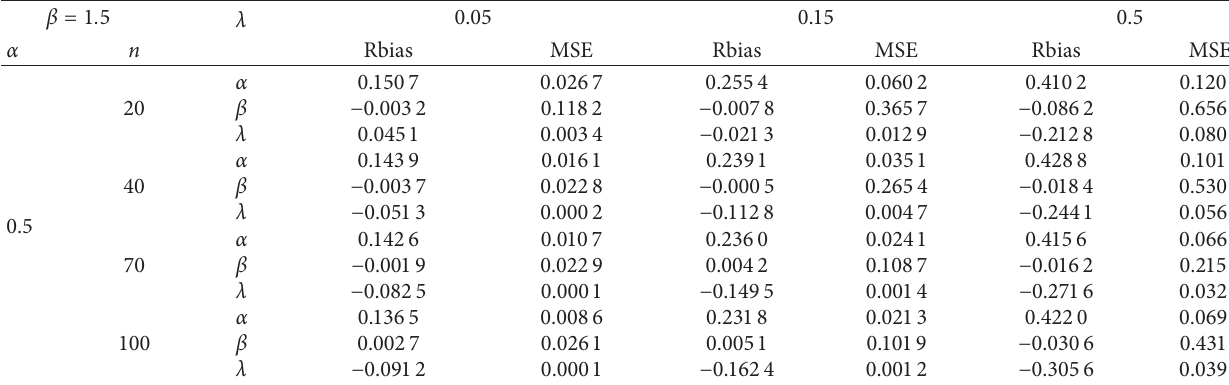
Table 3: Rbias and MSE for parameter of DEOWE distribution by using MLE when β � 1 . 5. β � 1 .